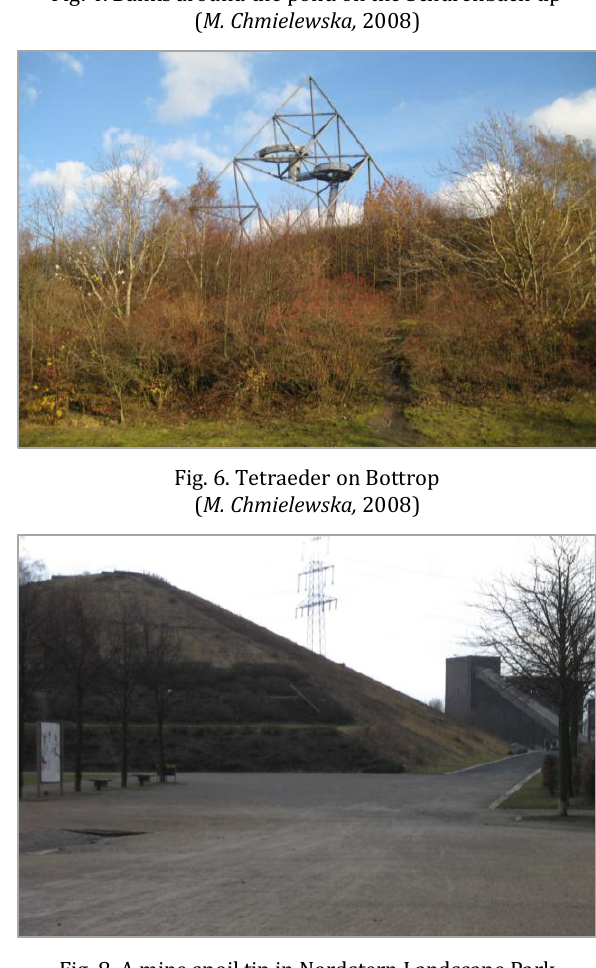
Fig. 3. Paths and viewing platform on the Hoheward tip